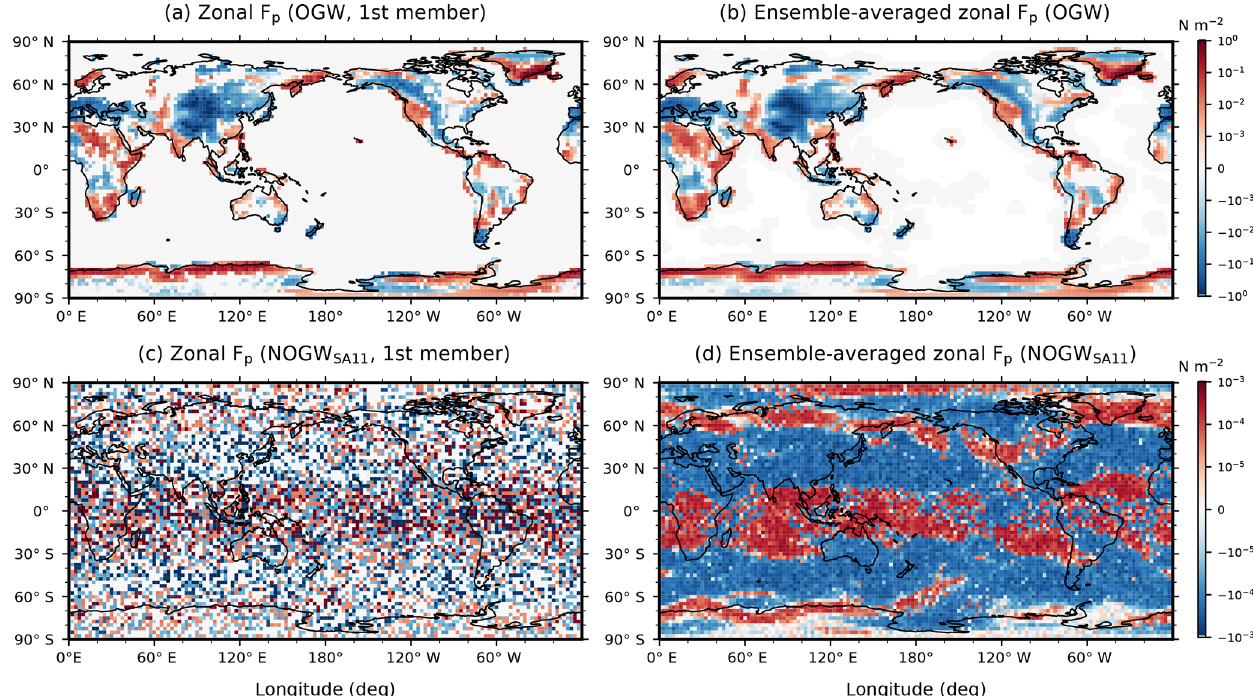
Figure 3. Longitude–latitude distributions of zonal pseudomomentum fluxes ( F p ) for OGW and NOGW SA11 at 00:00UTC on 20 Jan- uary 2009 on the 2 . 5 ◦ × 2 . 5 ◦ horizontal grid as follows: (a) zonal OGW F p above source layers for the first OGW ensemble member, (b) ensemble-averaged zonal OGW F p , (c) zonal NOGW F p at z = 6 . 8km for the first NOGW ensemble member, and (d) ensemble-averaged zonal NOGW F p at z = 6 . 8km. OGW F p is multiplied by an efficiency factor (0.125) as described in Richter et al.